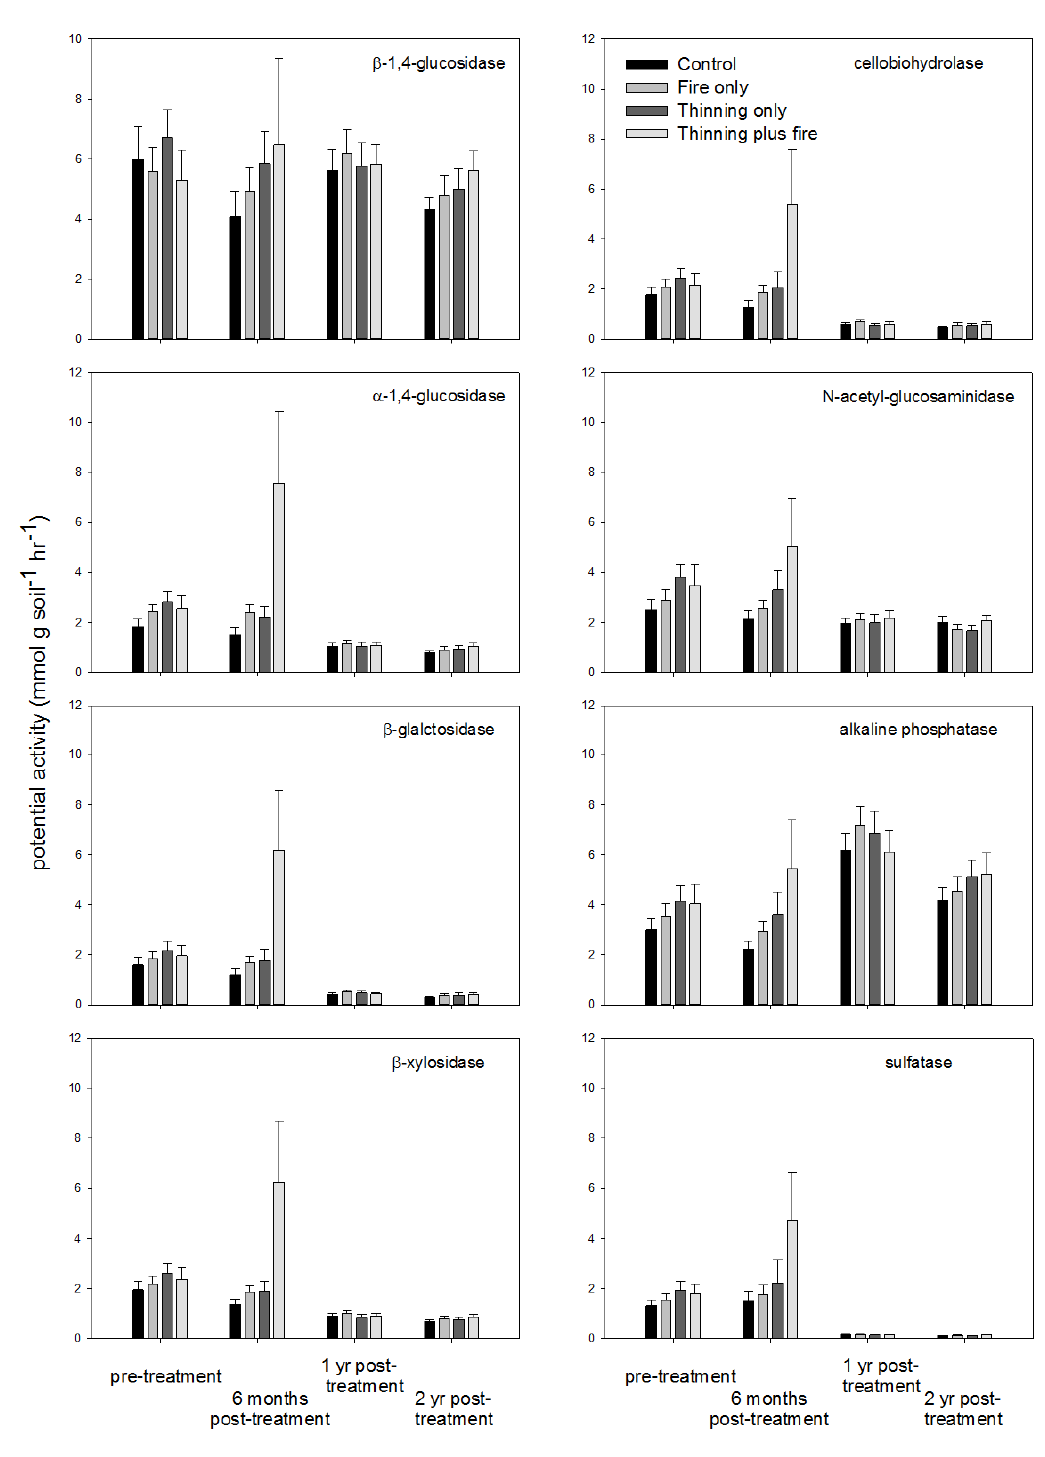
Figure 3. The observed mean + SE ( n = 3) potential activity of eight enzymes in mineral soil (0–5 cm) pre- and post-fuel reduction treatments at the Southwestern Plateau, Fire and Fire Surrogate study site. Error bars are not visible when errors were small.